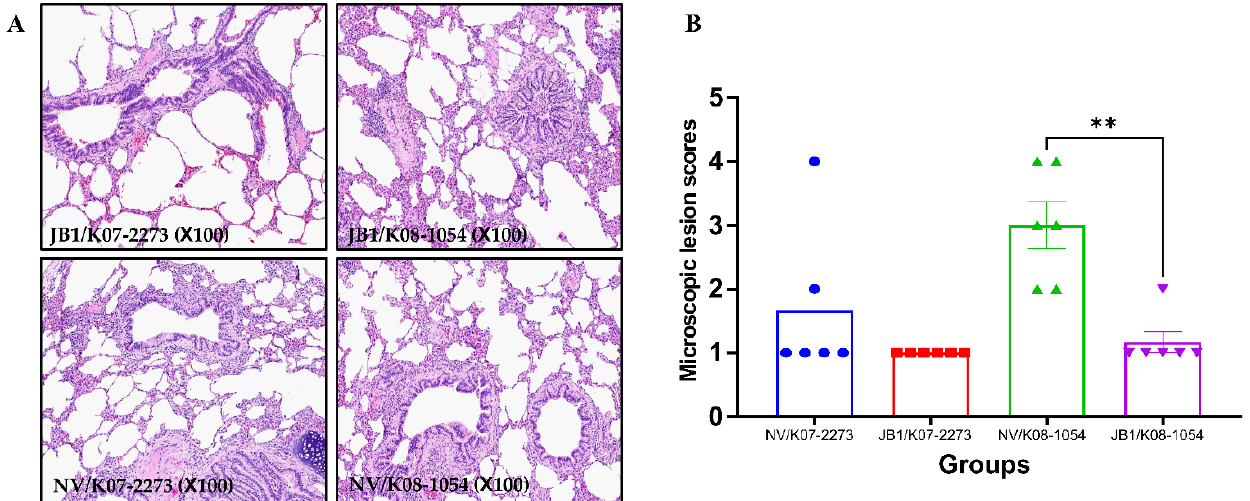
Figure 5. Histopathologic findings in the lungs of pregnant sows and piglets. ( A ) Representative pictures of lung lesions from sows. ( B ) Microscopic lesion scores of piglets (0, no lesion; 1, mild interstitial pneumonia; 2, moderate multifocal interstitial pneumonia; 3, moderate diffuse interstitial pneumonia; and 4, severe interstitial pneumonia). Data are shown as the means ± standard error of the mean (SEM). Asterisks indicate significant differences between the NV/K07–2273 and JB1/K07–2273 groups or between the NV/K08–1054 and JB1/K08–1054 groups (** p = 0.0065).